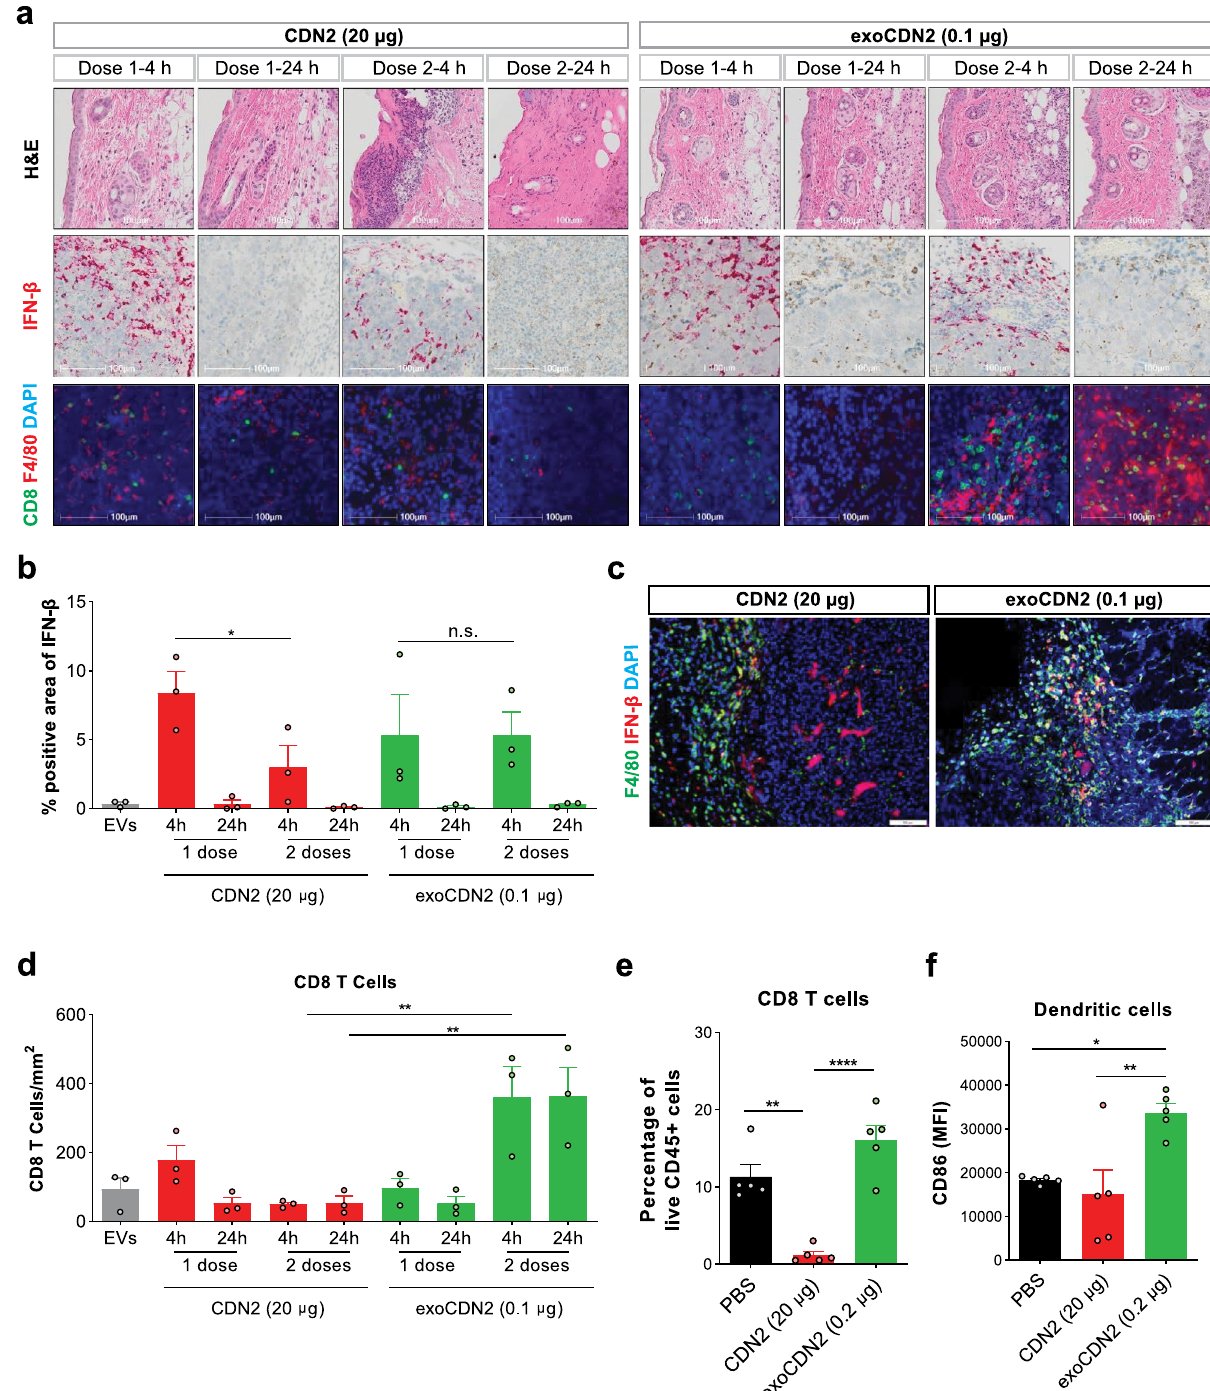
Fig. 4 exoSTING increases T cell in fi ltration in tumor microenvironment without immune cell ablation. a – c Unloaded EVs, CDN2 (20 µ g), and exoCDN2 (0.1 µ g) were injected intratumorally at Day 1 and Day 4 ( n = 3 animals per group) into B16F10 tumors. Tumors were collected at 4 and 24 h after fi rst dose and second doses. a Tumor sections were stained with H&E, or for IFN- β mRNA, CD8, and F4/80 expression. IFN- β positive area ( b ) and co-localization of F4/80 (green) and IFN- β (red) after free CDN2 (20 µ g) and exoCDN2 (0.1 µ g) treatment ( c ). CD8 positive cells ( d ) were measured. e , f Percentage of CD8 T cells in live CD45 + cells in tumors ( e ) and CD86 expression on dendritic cells ( f ) were measured by fl ow cytometry after two doses of PBS, CDN2 (20 µ g), and exoCDN2 (0.2 µ g) into B16F10 tumors ( n = 5 animals per group). Data are presented as means ± s.e.m from replicate samples as indicated. * P < 0.05; ** P < 0.01; **** P < 0.0001 by one-way ANOVA with Tukey ’ s multiple comparison test; n.s. non-signi fi CDN (20 µg) (Fig. 5c) to a similar degree. ExoSTING-treated viruses ” (adjusted P -value < 1e − 12), and “ Th1 pathway ” tumors (after two doses) were signi fi cantly enriched in “ Th1 and (adjusted P -value < 1e − 12) transcripts (Fig. 5c). In contrast, a Th2 activation pathway ” (adjusted P -value < 1e − 12), “ Role of second dose of free CDN led to a decrease in many of these genes. pattern recognition receptors in recognition of bacteria and